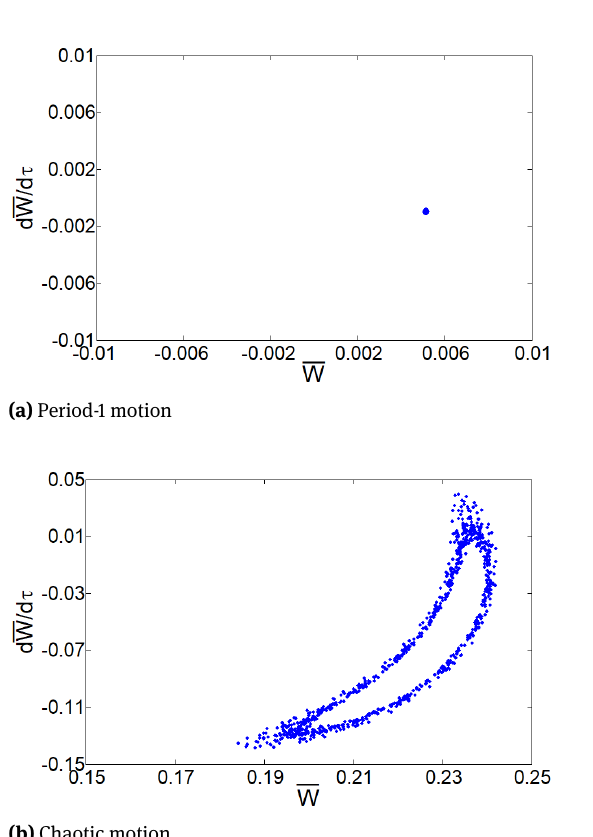
Fig. 4: Poincare maps of the micro-plate system for different dam-